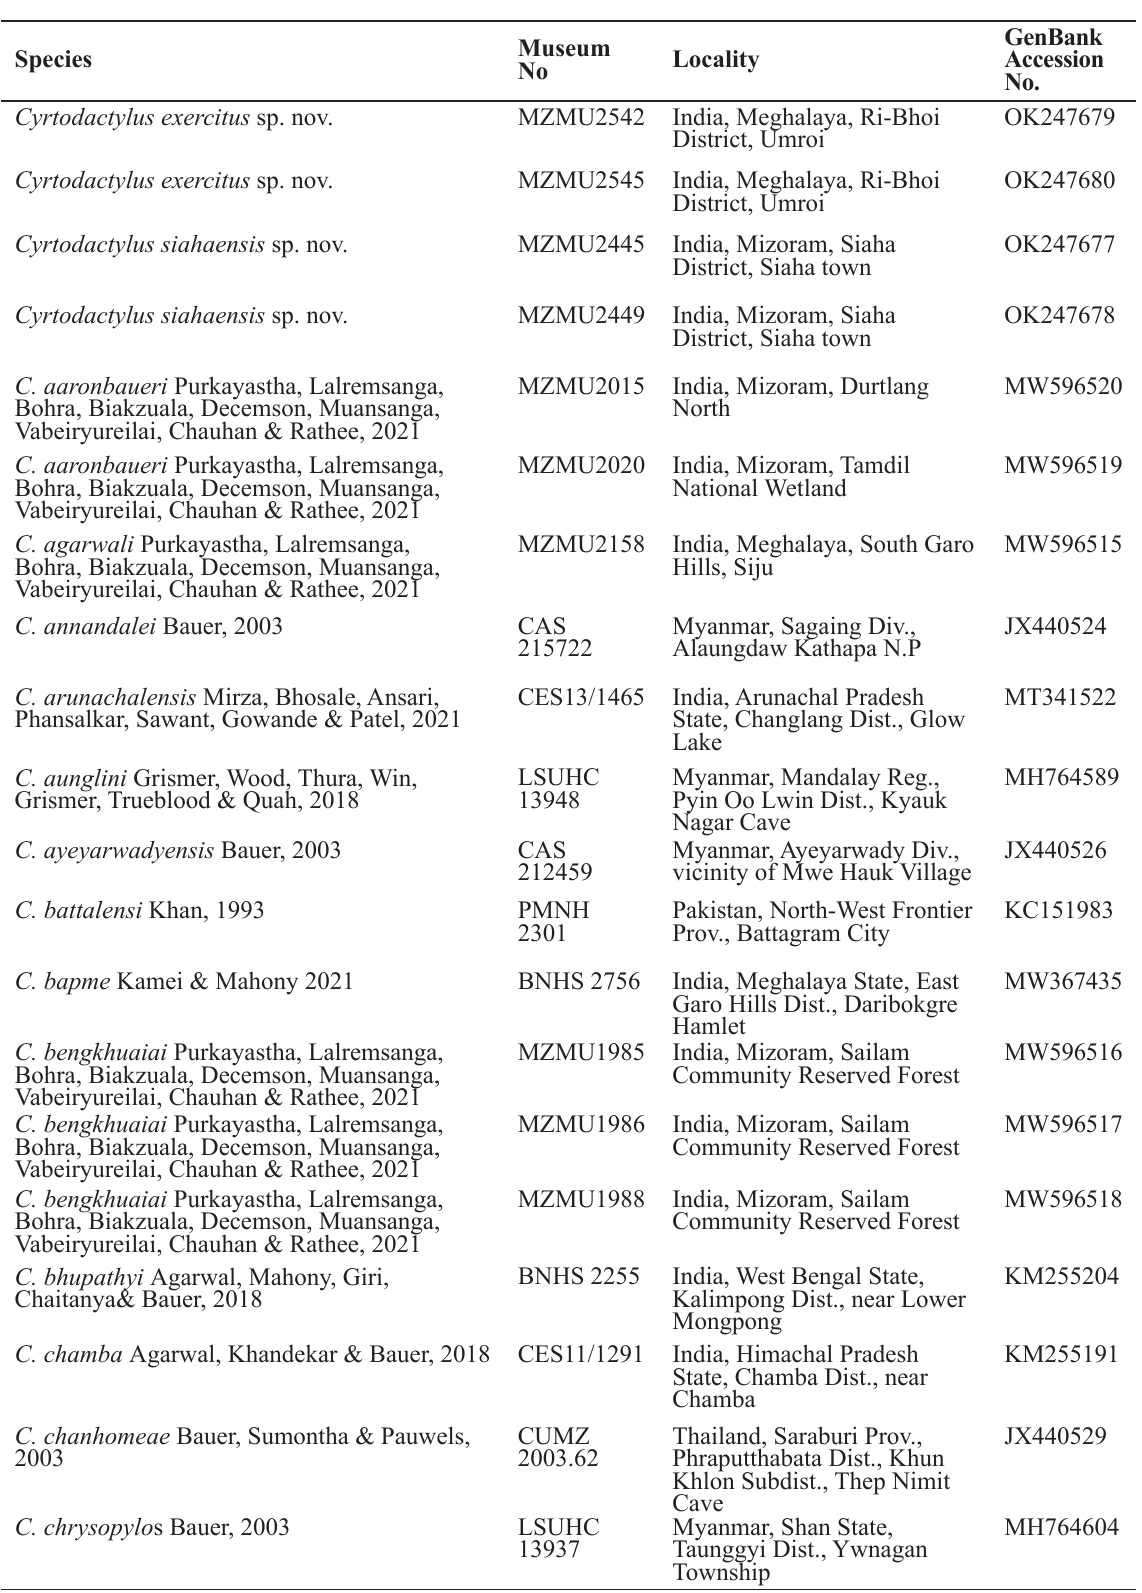
Table 1 (continued on the next 2 pages). List of Cyrtodactylus ND2 sequences used in this